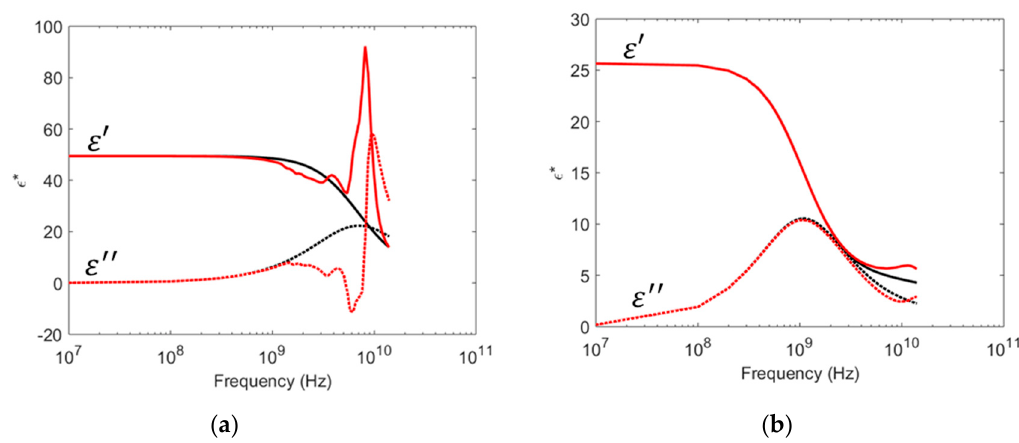
Figure 5. Comparison of the simulated relative permittivity spectra (red) and the empirical model given in Equation (2) of relative permittivity (black) for two liquid layers. The dielectric constant is plotted with solid lines and the dielectric loss factor with dotted lines. ( a ) 1.5 mm thick layer of 0.1 mol ethanol in